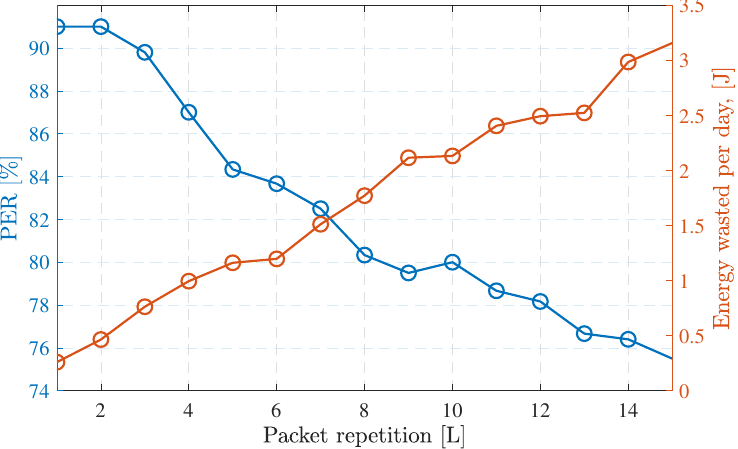
Figure 13. The PER and energy wasted per day with respect to varying packet repetitions, L , in case III assuming a transmit power P t = 27